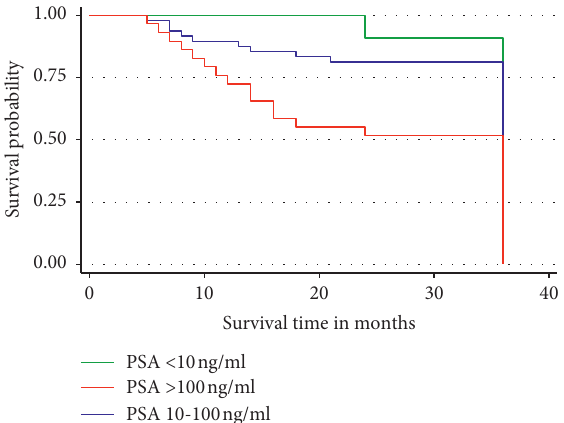
Figure 4: Three-year overall survival by PSA (at diagnosis) group of the patients. Patients with PSA > 100ng/ml show a relatively increased risk of dying compared to those with PSA ≤ 100ng/ml.